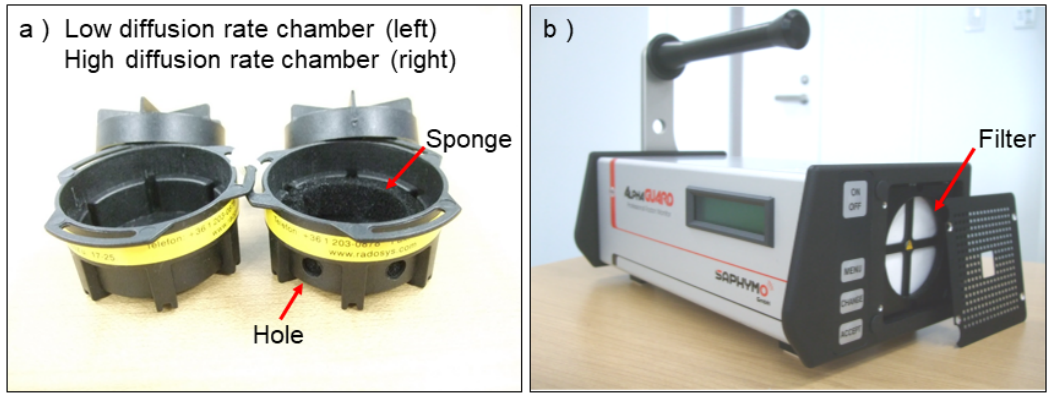
Figure 1. Views of the detectors examined in the present study: RADUET ( a ) and AlphaGUARD ( b